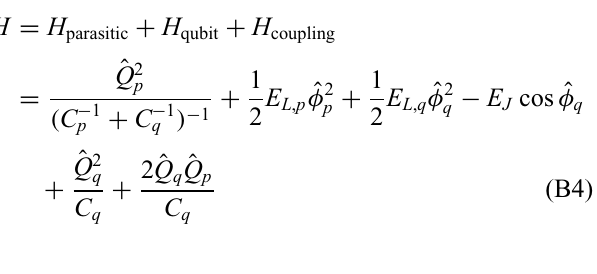
FIG. 5. The two-tone spectroscopy of all measured qubits. The labeled lines are obtained from a numerical optimization algorithm of the qubit and coupling parameters to maximize agreement with the full rf-SQUID and resonator model given in Eq. (2). In the case of qubits E and F, the observed parasitic qubit mode is added as a second coupled-resonator mode to the Hamiltonian. represent the inductive energies of the qubit and E L , p